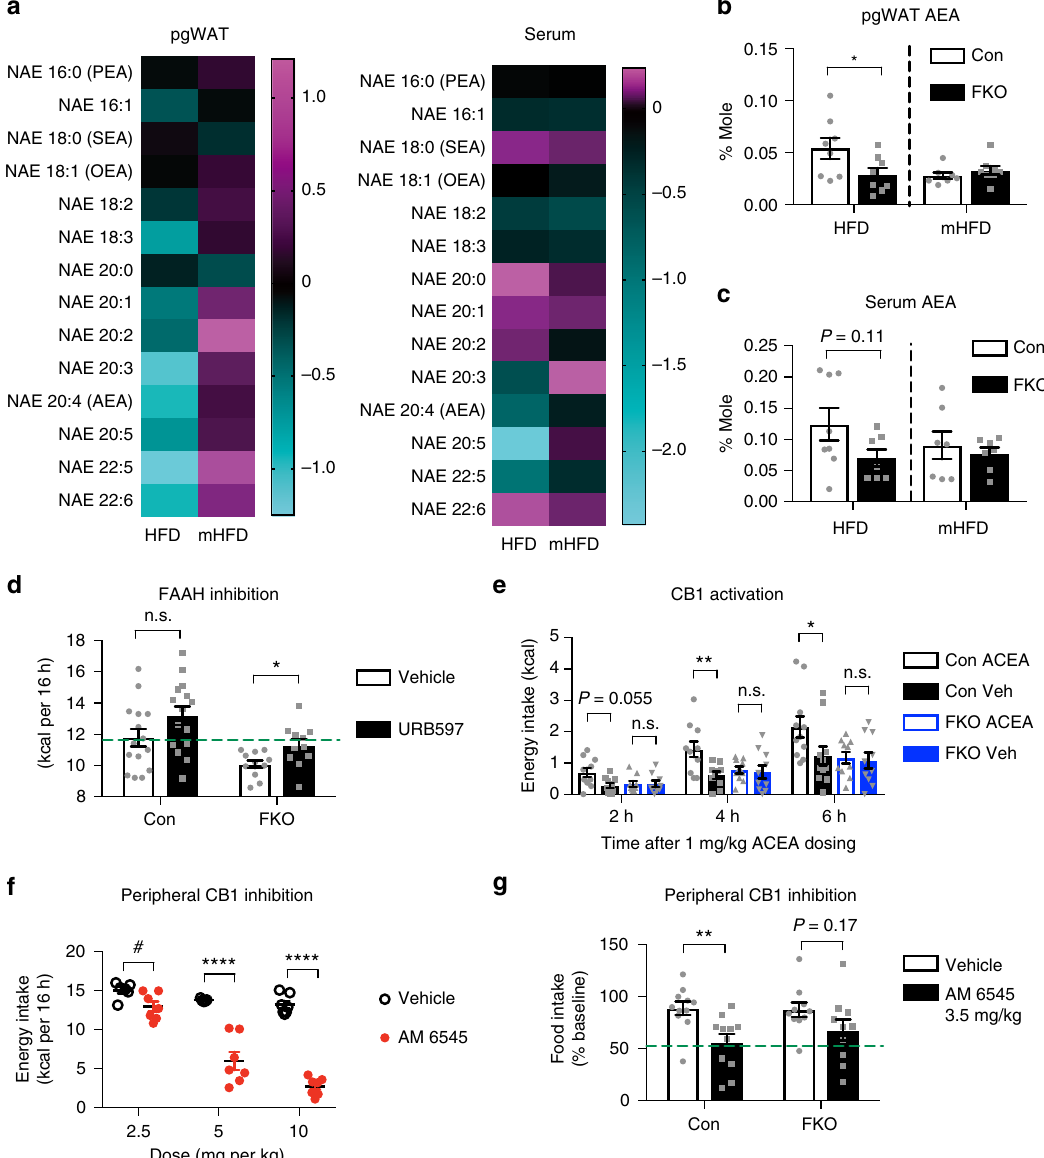
(Fig. 5e). On the other hand, we took advantage of the CB1 antagonist AM 6545 to inhibit peripheral CB1 signaling. Remarkably, peripheral inhibition of CB1 signaling decreased the energy intake of HFD-fed mice in a dose-dependent manner (Fig. 5f), even at doses (2.5 mg per kg and 5 mg per kg) that are not effective during chow feeding 10 . As expected, peripheral inhibition of CB1 signaling decreased the energy